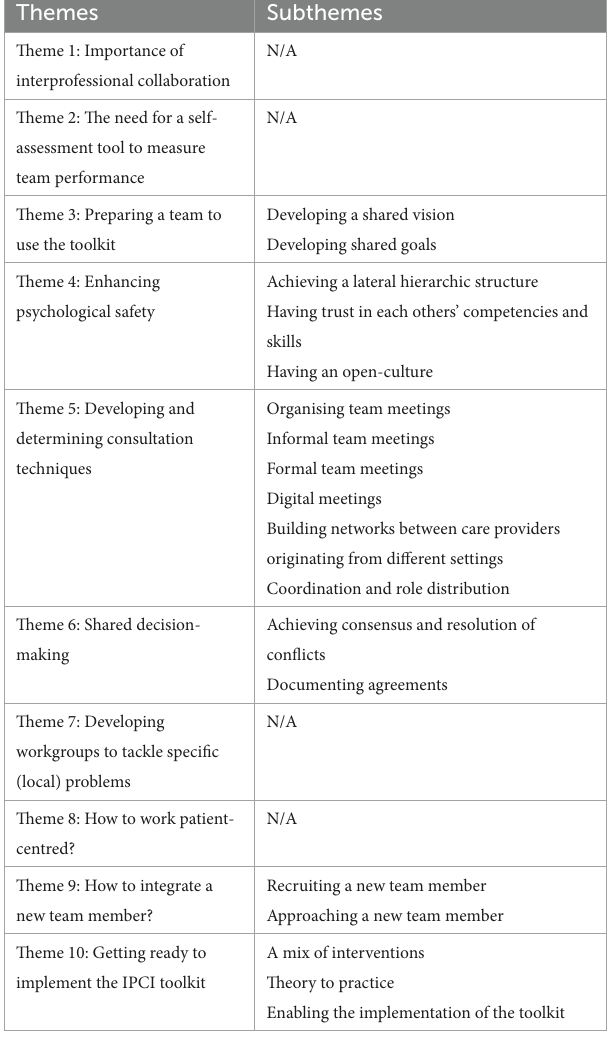
TABLE 6 Overview of the co-design workshop sessions: topic, date, # participants, background participants, and the questions. Workshops